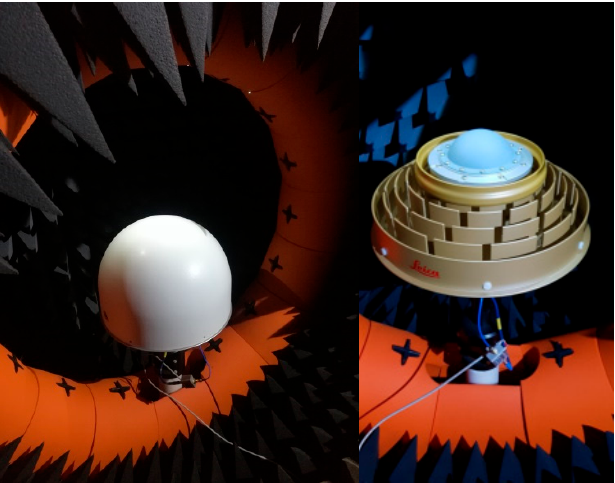
Figure 1. Novatel GNSS 750 ( left ) and Leica AR25 ( right ) antenna as measured at DLR’s near field antenna test facility in Oberpfaffenhofen.